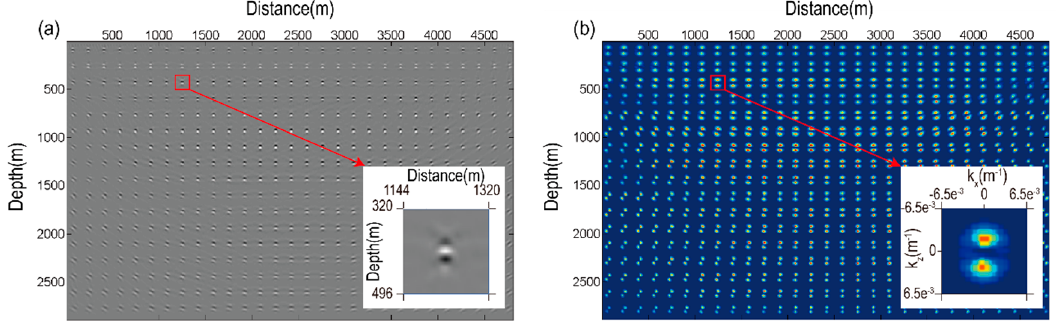
Figure 2. The produced PSFs of partial Sigsbee2a model ( a ) by using GBM with the data from Equation (7) and its spectrum in local wavenumber domain ( b ) by implementing FFT, where the pattern of the spectrum indicates the different illumination of the subsurface model.